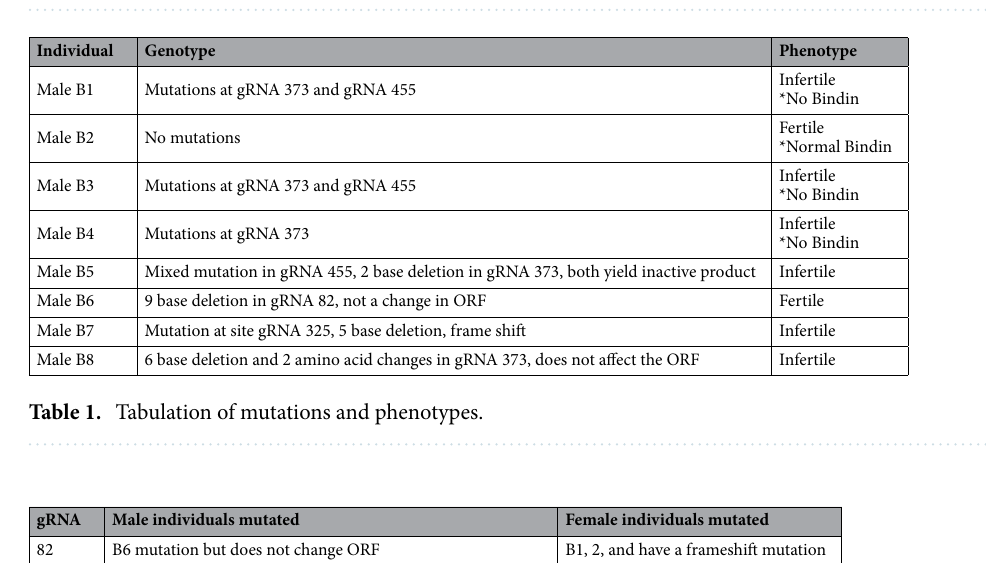
Figure 2. Fertilization assays using increasing sperm concentrations (from 100 sperm to over 10 million sperm per milliliter). Eggs of a single female were used for sperm from each male ( A – D ) throughout these assays. Two independent cycles of experiments were performed and one cycle of the dataset is shown. Bindin #2 represents sperm from an adult whose embryos were injected with Cas9 and gRNAs, yet no mutations were detectable in this animal. (Male B2 in Table #1).